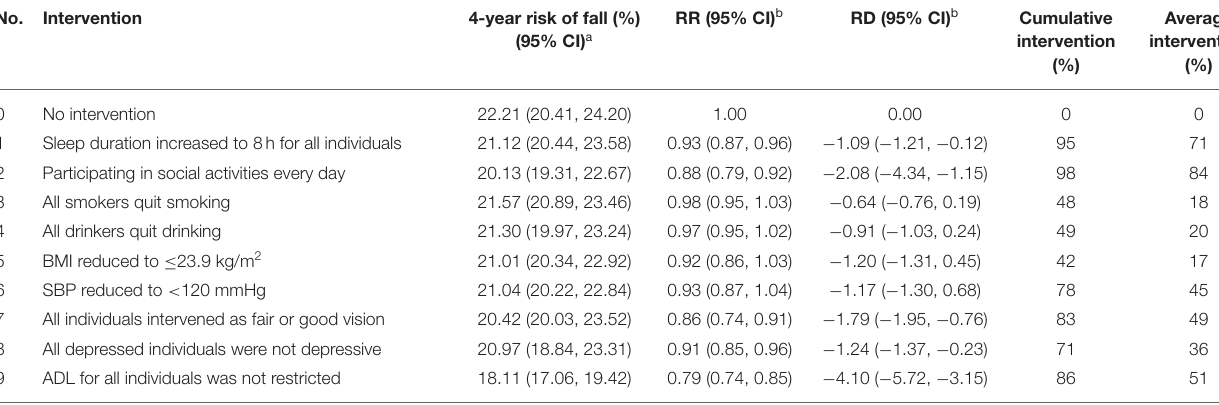
TABLE 4 | Risk of fall under intensive hypothetical interventions (CHARLS